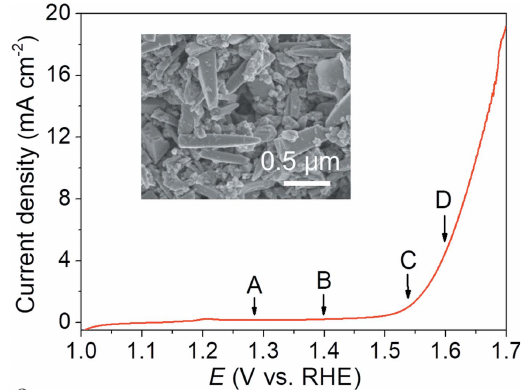
Figure 3 LSV curve recorded using the in situ cell without IR correction. The insert shows a transmission electron microscope image of the commercial IrO